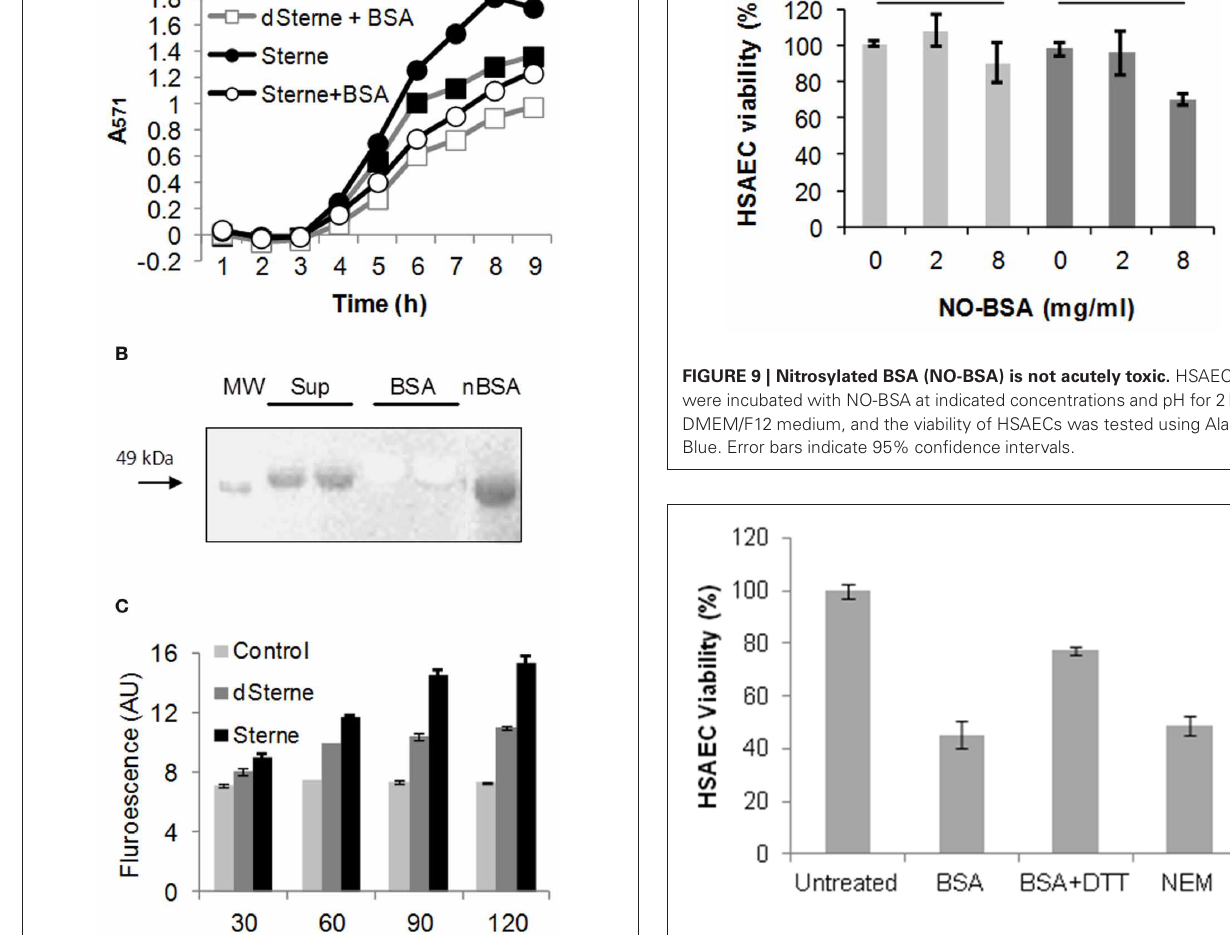
FIGURE 10 | Blocking of free SH groups of BSA does not reduce the toxicity of dSterne Sup grown in the presence of BSA. The protein was dissolved in 10ml of PBS, treated with 5mM DTT for 30min, and then dialyzed against two changes of 1l of PBS for 24h. The reduced BSA was then modified by NEM (125 μ M) for 1h at 37 ◦ C and dialyzed against two changes of 1l of PBS overnight. The modified and mock-treated BSA was used to supplement the DMEM/F12 medium at 2mg/ml. Bacterial cultures were grown for 24h and Sups were tested for toxicity using HSAECs and the Alamar Blue viability assay. Error bars indicate 95% confidence